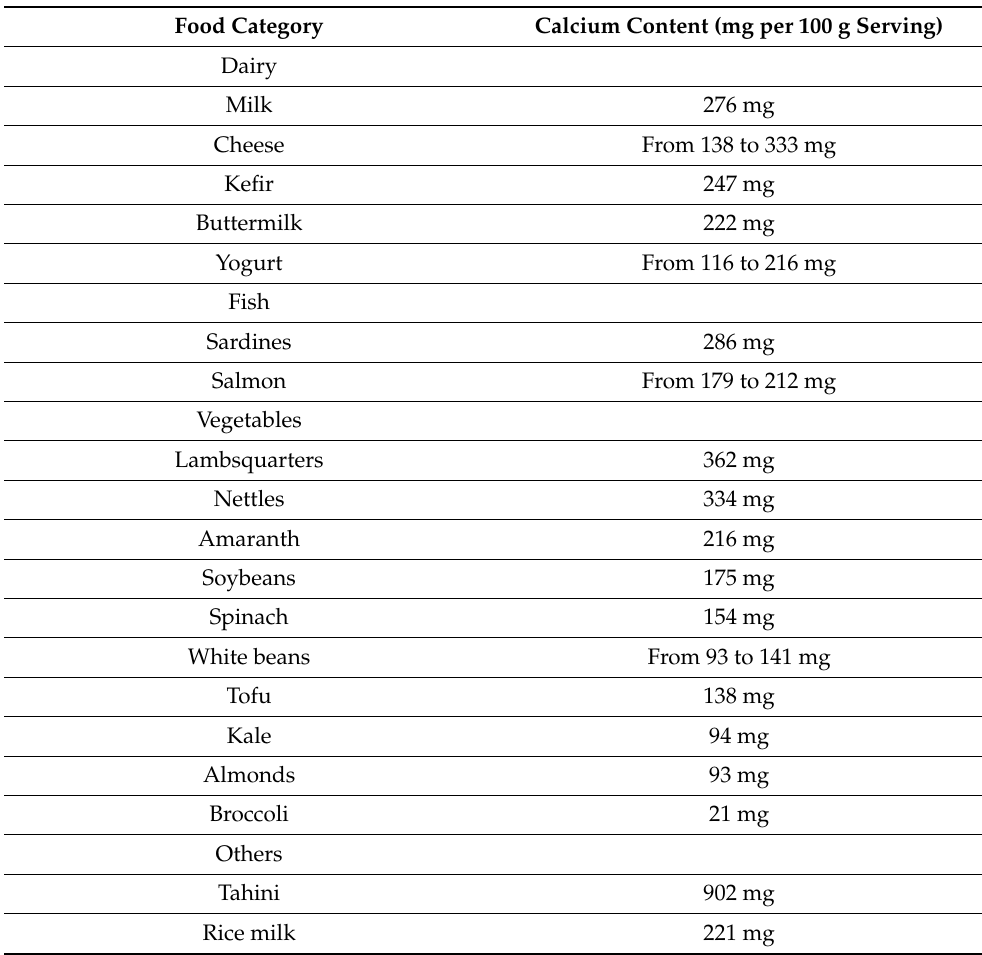
Table 1. Foods with the highest calcium